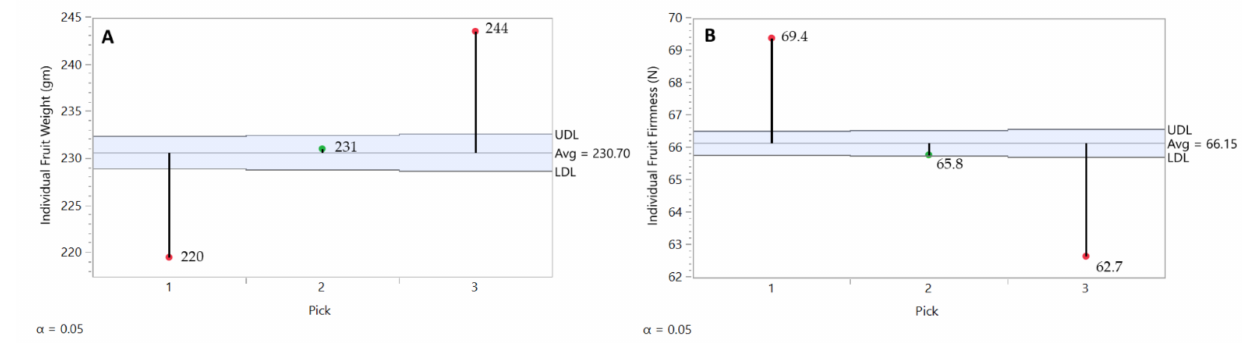
Figure 8. Picking time effect at harvest on ‘Honeycrisp’ fruit weight ( A ) and flesh firmness ( B ) with all rootstocks and years combined. As expected, fruit size increased with each subsequent pick, and fruit firmness decreased. JMP Fit XY Platform, Analysis of Means of Proportions of the binomial dataset, alpha =